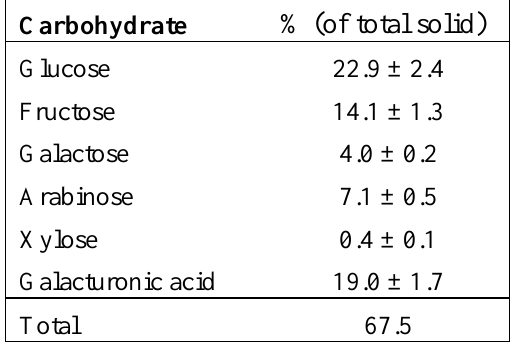
Table 1 . Yields of the carbohydrates released during enzymatic hydrolysis of the orange